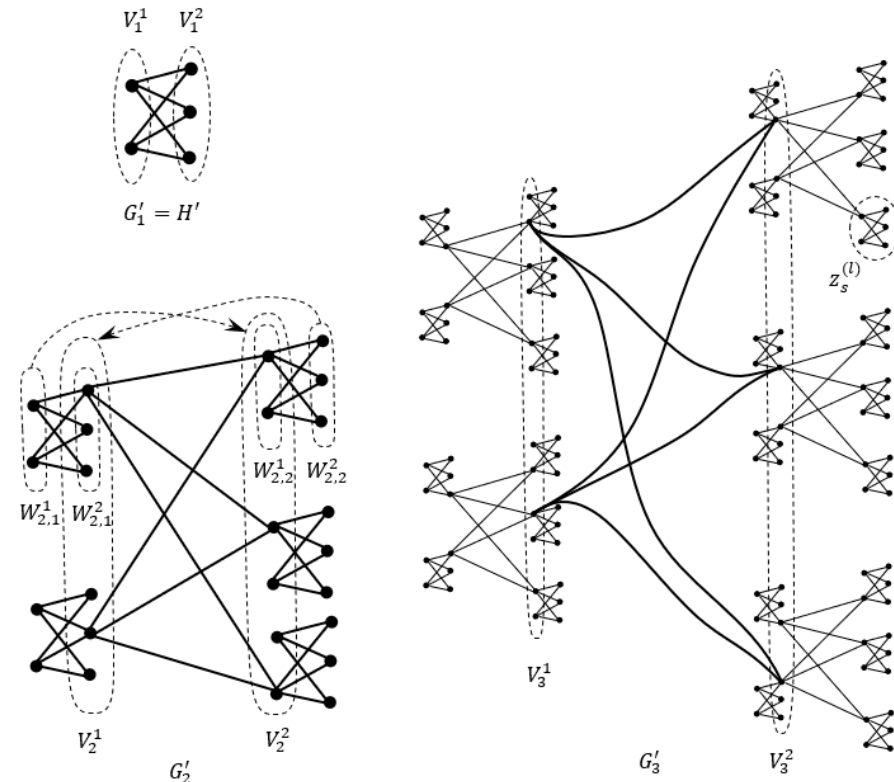
Figure 10. Prefractal graph G (cid:48) generated by a complete bipartite seed, preserving the adjacency of old edges.